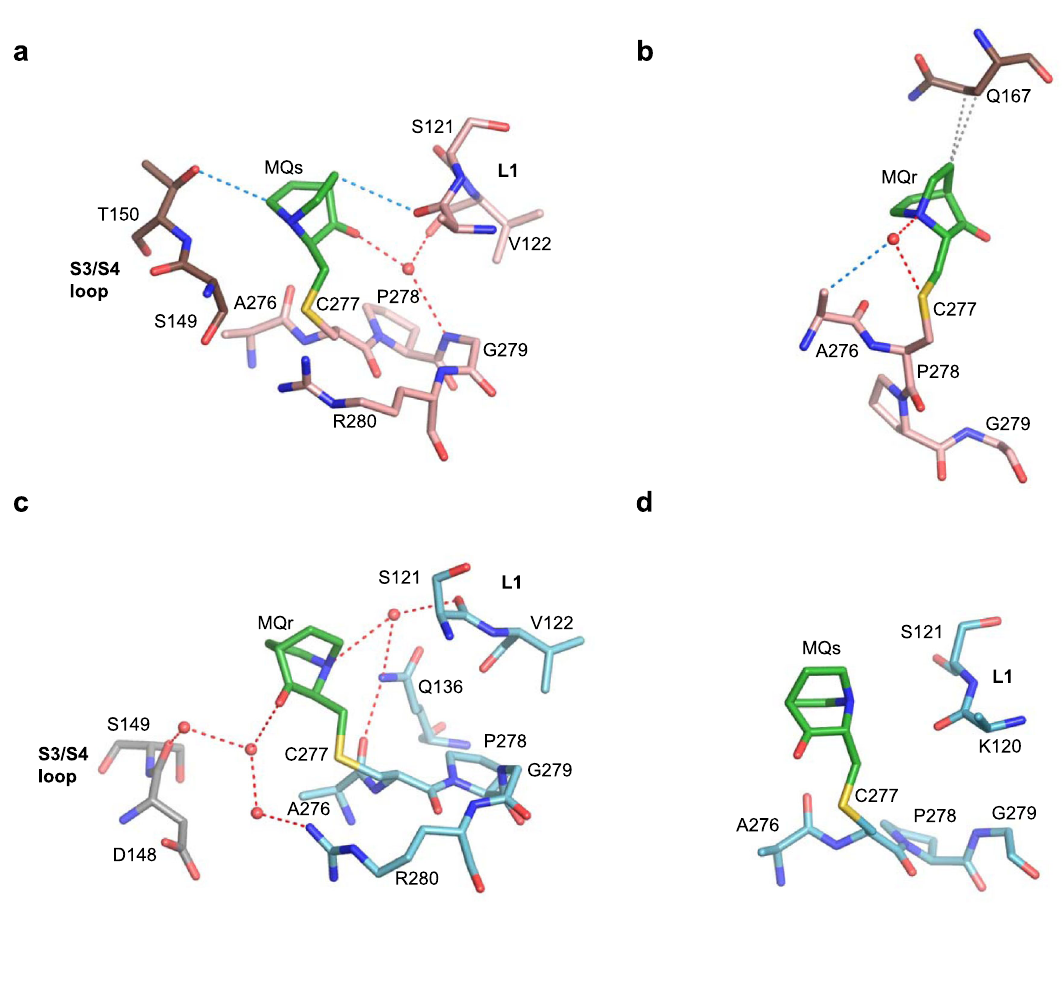
Fig. 4 MQ bound to C277 in R273H and R273C mutants. The MQ-C277 conjugates and interactions with the molecular environment are from the following crystal structures. a R273H-MQ (I), monomer D and monomer C. b R273H-MQ (II), monomer C and symmetry-related monomer D. c R273C- MQ (I), monomer B and symmetry-related monomer A. d R273C-MQ (II), monomer B. The MQ-C277 conjugates show a large variance in MQ orientation and interactions. Structure representations and color codes are as in Figs. 1 –